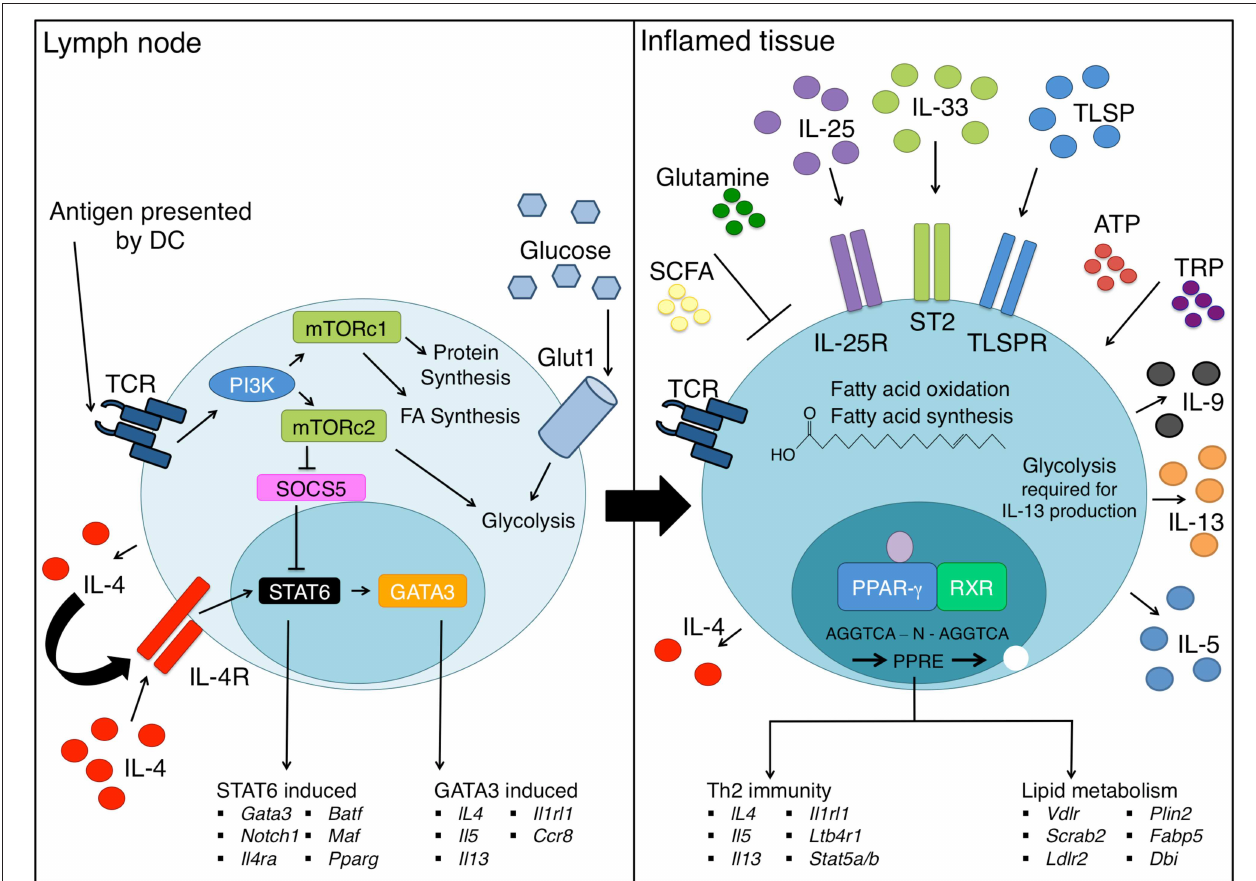
FIGURE 1 | Th2 cell differentiation requires extensive metabolic reprogramming. Upon encountering cognate antigen in the lymph node, naive CD4T helper cells differentiate into Th2 cells under the influence of the IL-4-STAT6-GATA3 axis. Concurrently, changes in energy requirements occur as a Th2 cell differentiates, which requires an increase in glucose uptake via GLUT1 and marked upregulation of glycolysis. mTORc1 senses nutrient availability and co-ordinates metabolism in T helper cells, and mTORc2 promotes Th2 cell differentiation through several mechanisms. As Th2 cells enter inflamed tissue sites such as the lung, they continue to differentiate through exposure to a range of inflammatory cytokines including TSLP, IL-25, and IL-33 that promote production of effector cytokines such as IL-5, IL-9, and IL-13. In addition, PPAR- γ drives expression of lipid metabolic genes such as Fabp4 and Vdlr as well as genes critical to Th2 cell effector functions, such as ST2 ( Il1rl1 ) and Il5. Extracellular metabolites present in the tissues including SCFA, ATP, and TRP can further promote Th2 cell differentiation and/or function. On the other hand, glutamine obtained from the diet potentiates Th1 cells at the expense of Th2